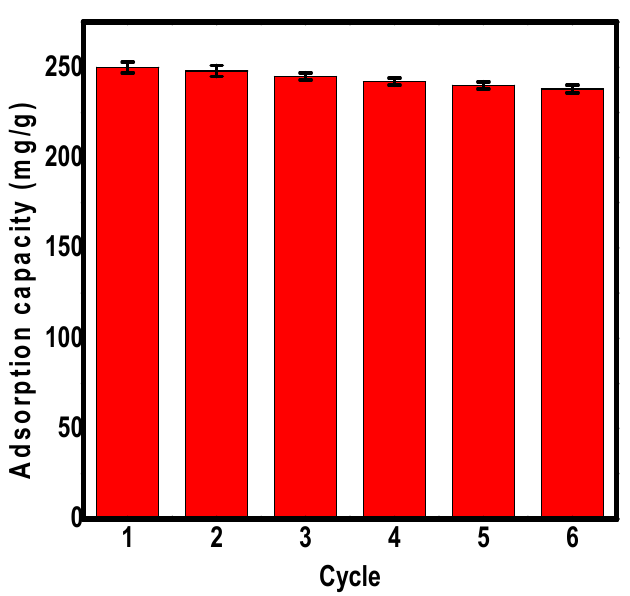
Figure 7. Pb 2+ ions removal on the surface of recycled Fe 3 O 4 /N@C nanocomposite up to six successive cycles.